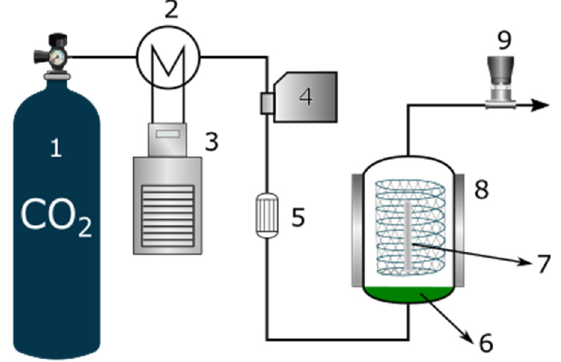
Figure 1. Schematic diagram of the supercritical solvent impregnation process. 1: CO 2 cylinder; 2: condenser; 3: cold bath; 4: CO 2 pump; 5: heat exchanger; 6: ethanolic OLE; 7: polymer filament; 8: high-pressure vessel; 9: automatic BPR.